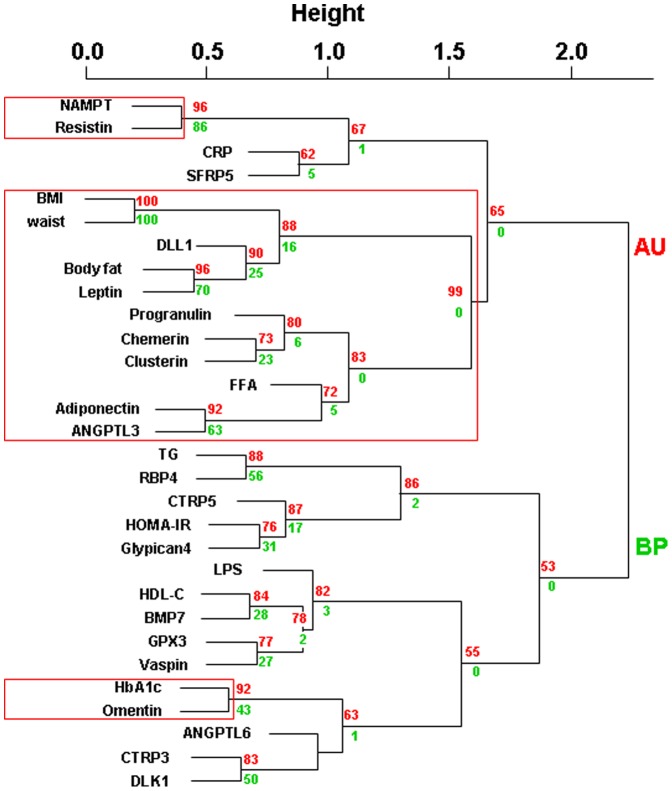
Hierarchical clustering of serum adipokine concentrations and clinical parameters in controls without type 2 diabetes (n = 72).We provide approximately unbiased (AU) p-values and bootstrap probability (BP) values as measures of certainty for clusters. Values are based on 10,000 bootstrapping replicates. AU≥90% was considered as strong evidence for the cluster and is marked by red rectangles (only largest possible clusters are marked). Abbreviations: BMI, body mass index; HOMA-IR, Homeostatic Model Assessment; FFA, free fatty acids; CRP, high sensitive C-reactive protein; ANGPTL 3, angiopoietin-like protein 3; ANGPTL 6, angiopoietin-like protein 6; BMP7, bone morphogenetic protein 7; CTRP3, complement C1q tumor necrosis factor-related protein 3; CTRP5, complement C1q tumor necrosis factor-related protein 5; LPS, Lipopolysacharid (Endotoxin); GPX3, glutathione peroxidase 3; DLL1, delta-like protein 1; DLK1, preadipocyte factor 1; NAMPT, nicotinamide phosphoribosyltransferase (visfatin); RBP4, retinol binding protein 4; SFRP5, secreted frizzled-related protein-5; TG, triglycerides.